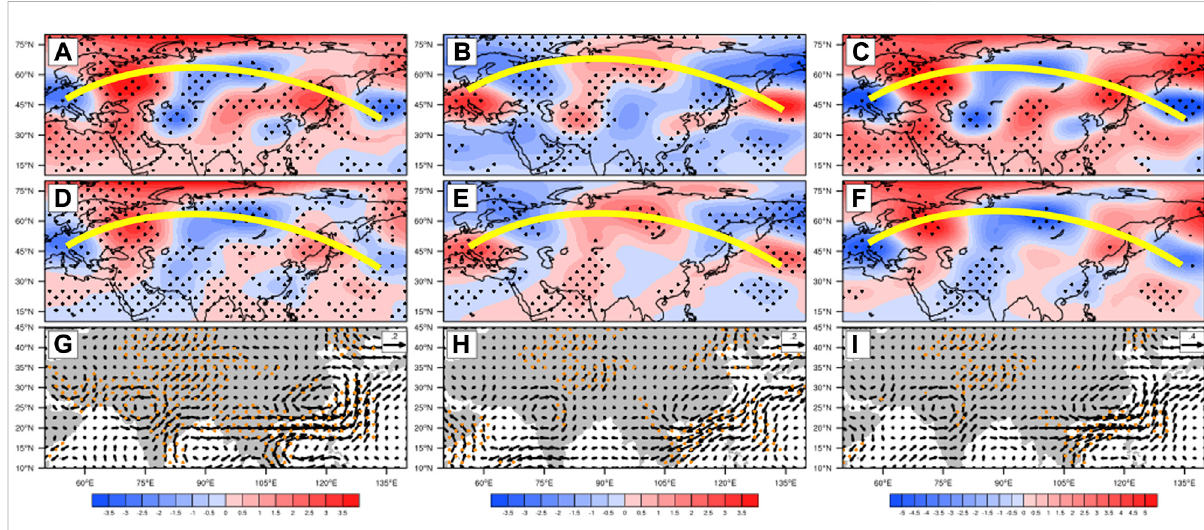
FIGURE 2 Top row: composite 30 – 90 days fi ltered geopotential height anomalies at 200 hPa (unit: gpm). Middle row: composite 30 – 90 days fi ltered geopotential height anomalies at 500 hPa (unit: gpm). Bottom row: composite 30 – 90 days fi ltered wind anomalies at 850 hPa (unit : ms − 1 ). (A,D,G) for P2 positive years, (B,E,H) for P2 negative years, and (C,F,I) for differences between the composites of positive years and negative years. Dotted areas indicate the values are signi fi cant at/above the 95% con fi dence level by Student ’ s t test. Yellow solid lines in a-f represent the “ Silk Road ” teleconnection wave trains.